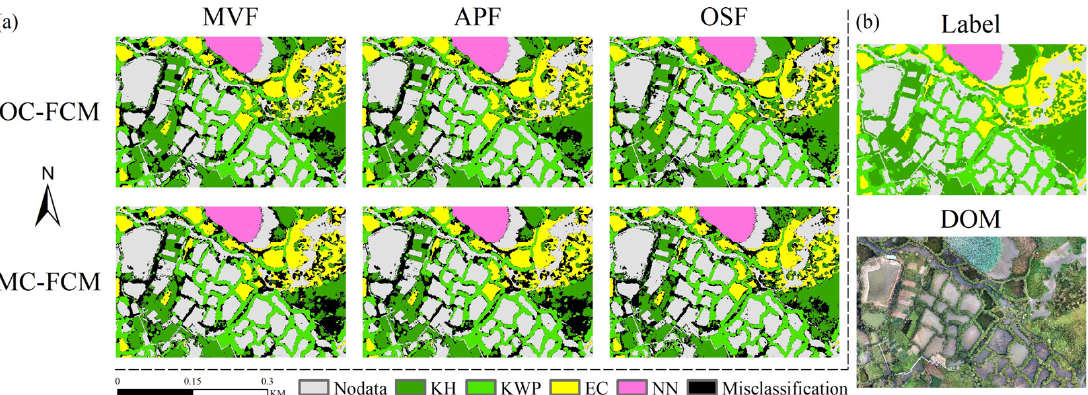
Figure 20. Results of the OC-FCM and MC-FCM based on different fusion strategies for karst wetland vegetation. ( a ) OC-FCM and MC-FCM, ( b ) semantic labels and UAV data.